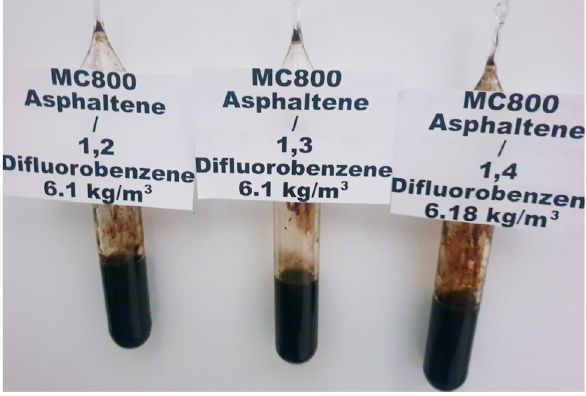
Figure 3: The sample is degassed and sealed in Pyrex